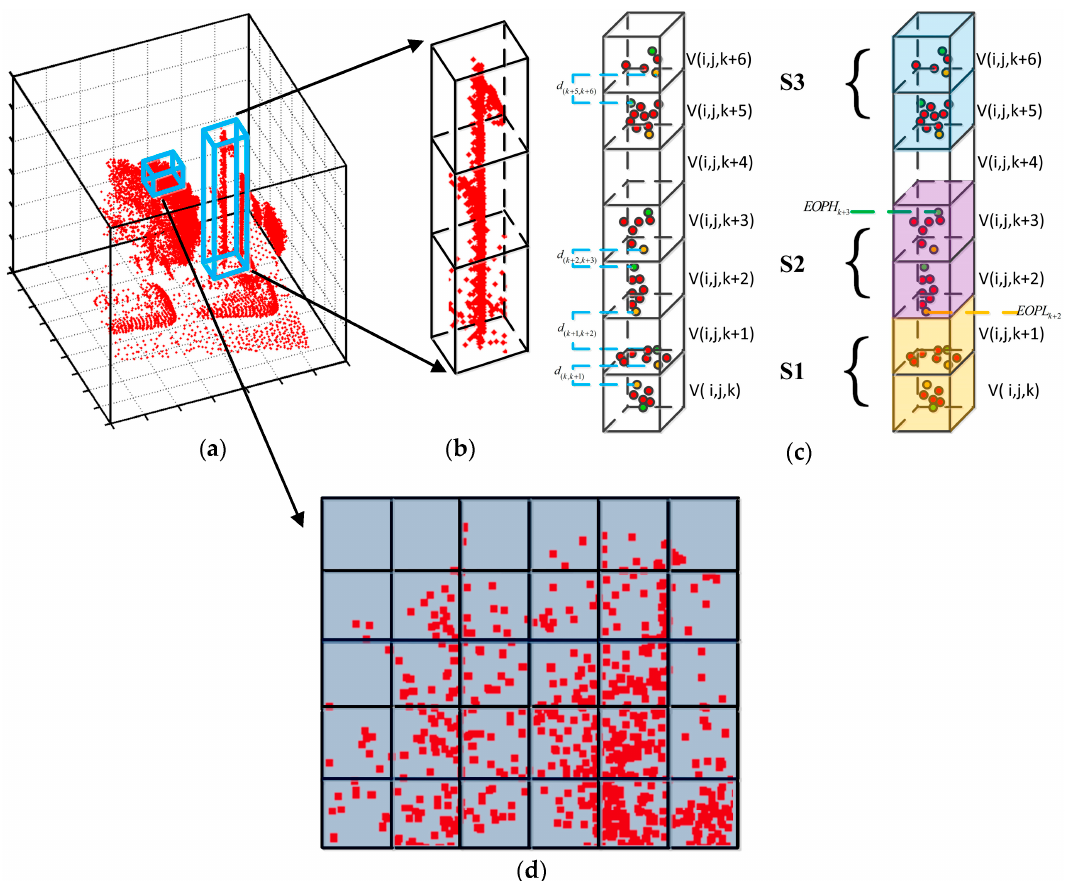
Figure 2 . Construction of voxel group. ( a ) Point clouds distribution of several objects in a 3D voxel grid system; ( b ) Street lamp point clouds and the generated voxels; This is a typical case in which the voxels with the same horizontal and vertical coordinates with adjacent elevations belong to the same target; ( c ) Schematic of the process of dividing the voxel distributions on the same vertical direction; ( d ) Profile of part canopy of a street tree, a case that adjacent voxel within points belong to one object have little elevation differences .